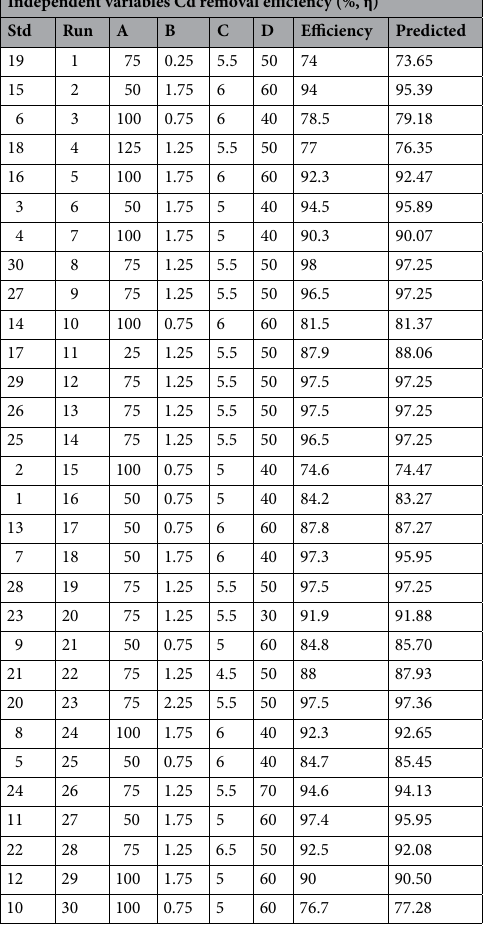
Table 3. Batch mode adsorption process parameters used in RSM with the equivalent experimental and predicted values for the